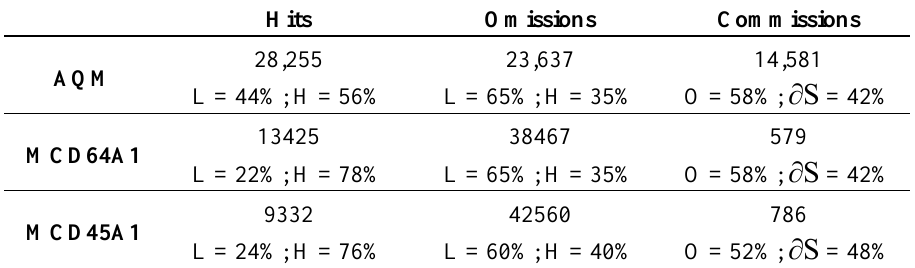
Table 3. Number of hits, omission errors, and commission errors when comparing AQM and MCD64A1 and MCD45A1 versus TM reference maps over Jalapão during the study period. For hits and omissions, each cell also presents the fractions of low burned pixels (L), i.e. , with less than 50% burned area in the Landsat reference map and of highly burned pixels (H), i.e. , with more than 50% burned, whereas for commissions each cell also presents the fractions of pixels located in the border of scars (∂S) or out of both scars and borders (O). Hits